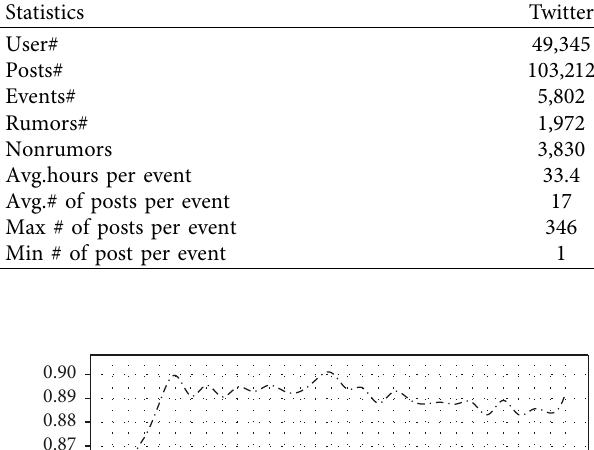
Figure 6: Schematic diagram of evaluation index loss changes. Table 3: Hyperparametric